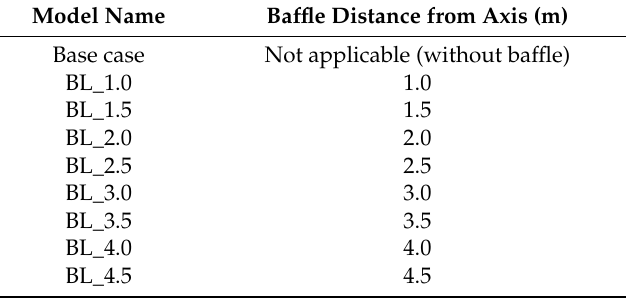
Table 1. The eight models with different baffle distances from the central axis and control model (base case) for the case without baffle: Note that the number in each model name means the distance